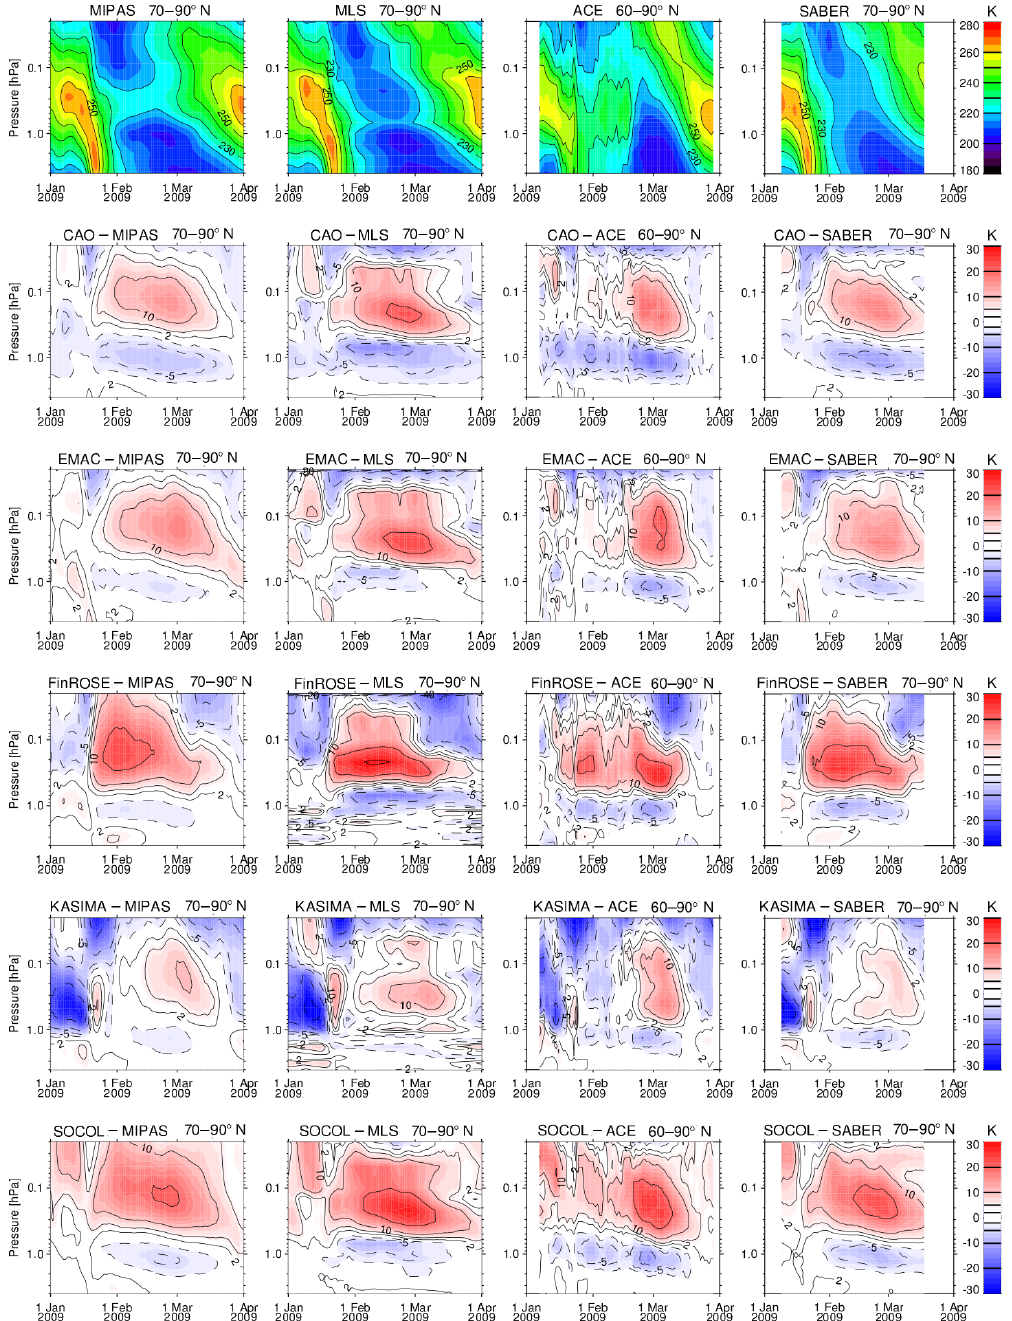
Figure 18. Top: temporal evolution of daily averaged polar cap temperatures at 4–0.02hPa observed by MIPAS-NOM, MLS/Aura, ACE- FTS, and SABER (from left to right). Bottom: corresponding differences between temperatures simulated with the “medium-top” models (CAO, EMAC, FinROSE, KASIMA, and SOCOL) and the